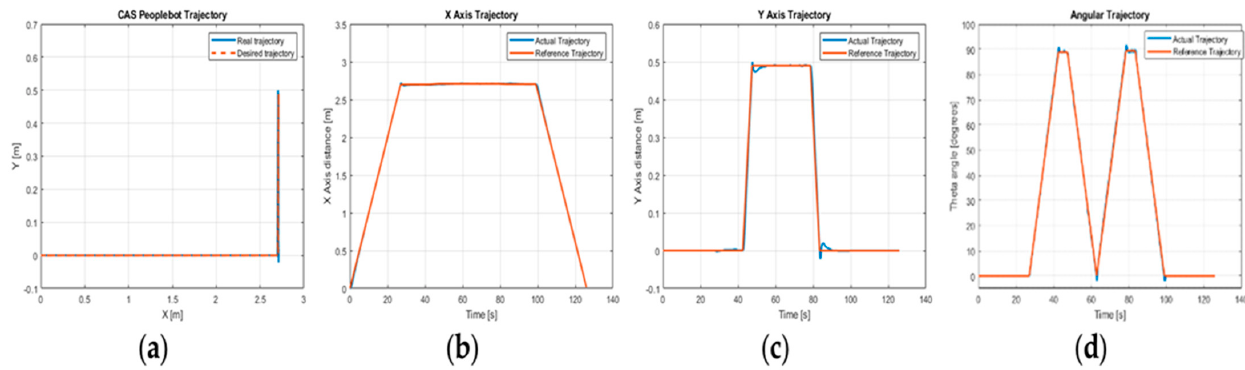
Figure 23. Desired and real trajectories of ARS PeopleBot based on Trajectory Tracking Sliding Mode Control: ( a ) complete trajectory, ( b ) X axis, ( c ) Y axis, and ( d ) angular trajectories.